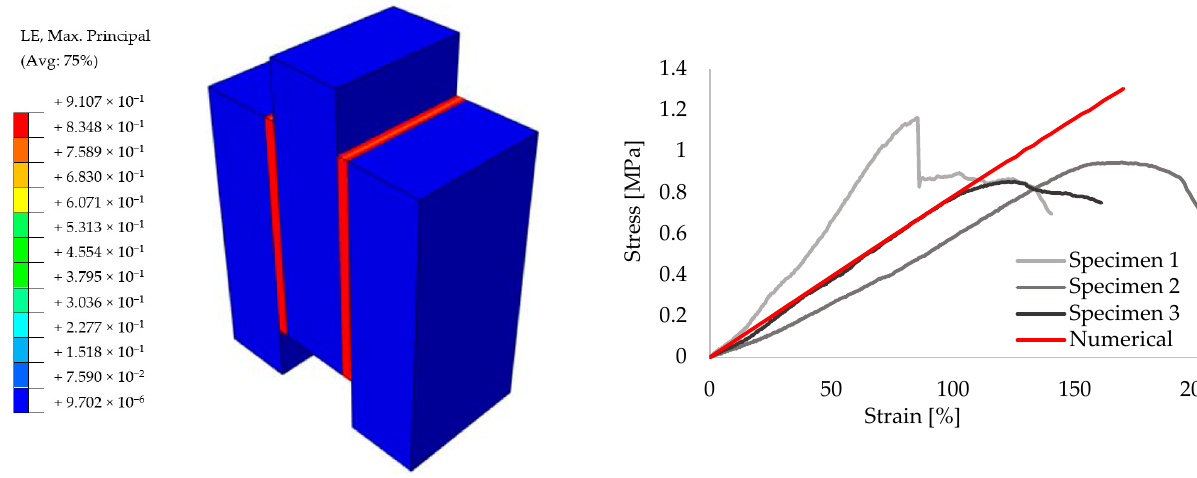
Figure 14. Shear results for the small size specimens with mortar: true strain diagram ( left ) and comparison of the numerical and experimental tests ( right ).